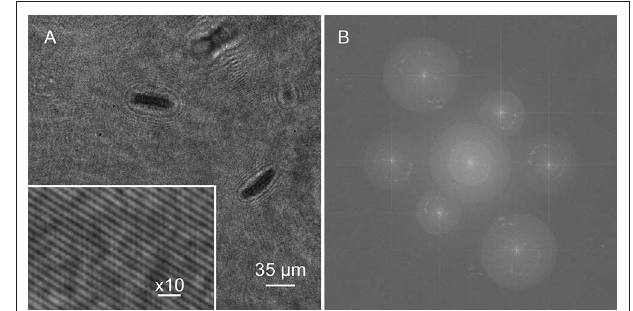
FIGURE 6 | Holograms and Fourier transform. (A) Hologram of Euglena culture with inset showing fringes. (B) Fourier transform.